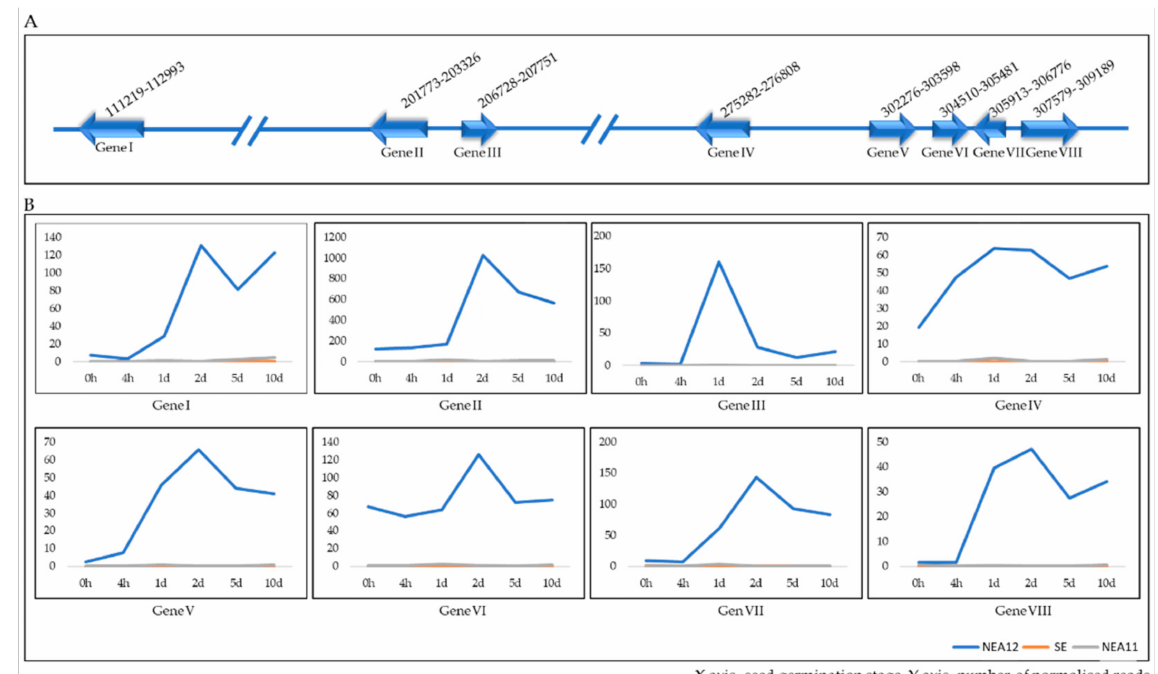
Figure 7. ( A ) Schematic representation of the novel potential secondary metabolite biosynthesis gene cluster (Gene I— NEA12_g03979, Gene II—NEA12_g03980, Gene III—NEA12_g03981, Gene IV—NEA12_g03982, Gene V—NEA12_g03983, Gene VI—NEA12_g03984, Gene VII—NEA12_g03985, Gene VIII—NEA12_g03986) in NEA12 pacBio contig 010_1-500000; ( B ) Expression of NEA12_g03979—NEA12_g03986 genes in NEA12 compared to SE and NEA11 at different stages of symbiotum establishment in seed